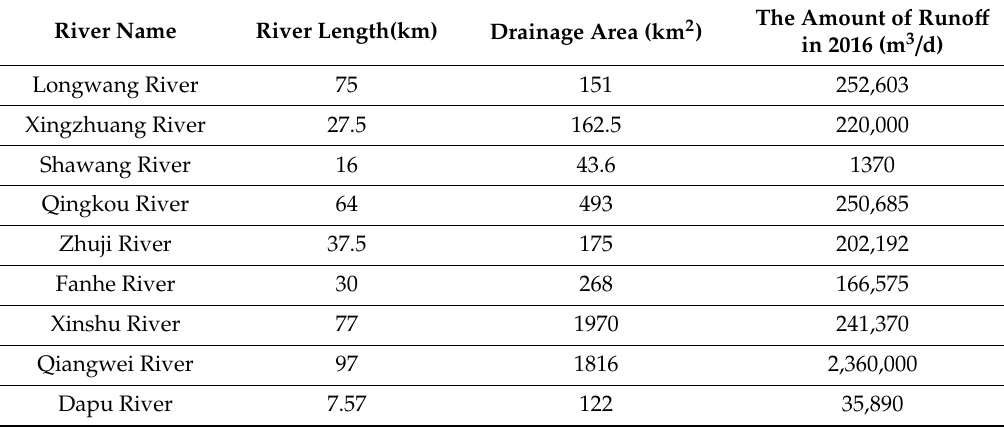
Figure 1. The location of study area. Table 1. The length and drainage area of main rivers in Haizhou